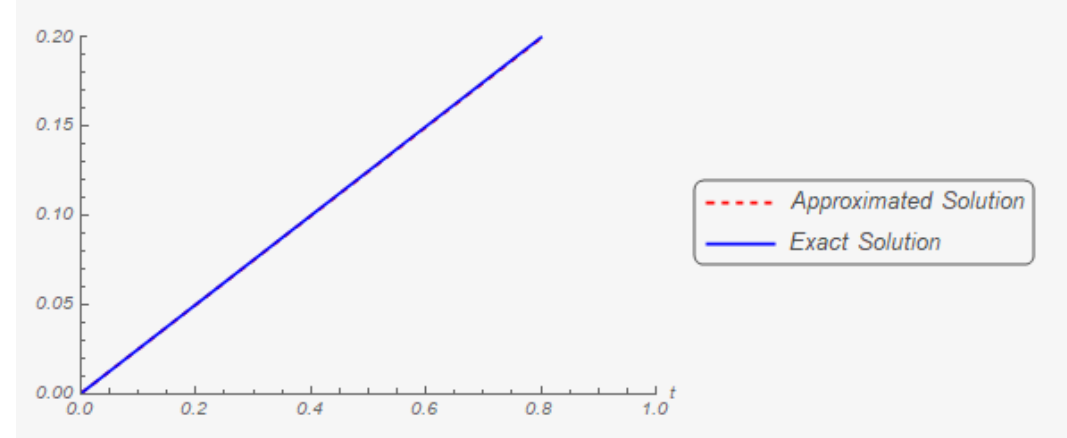
Figure 12. The second component of the exact solution and its two hundredth and fifth approximation.